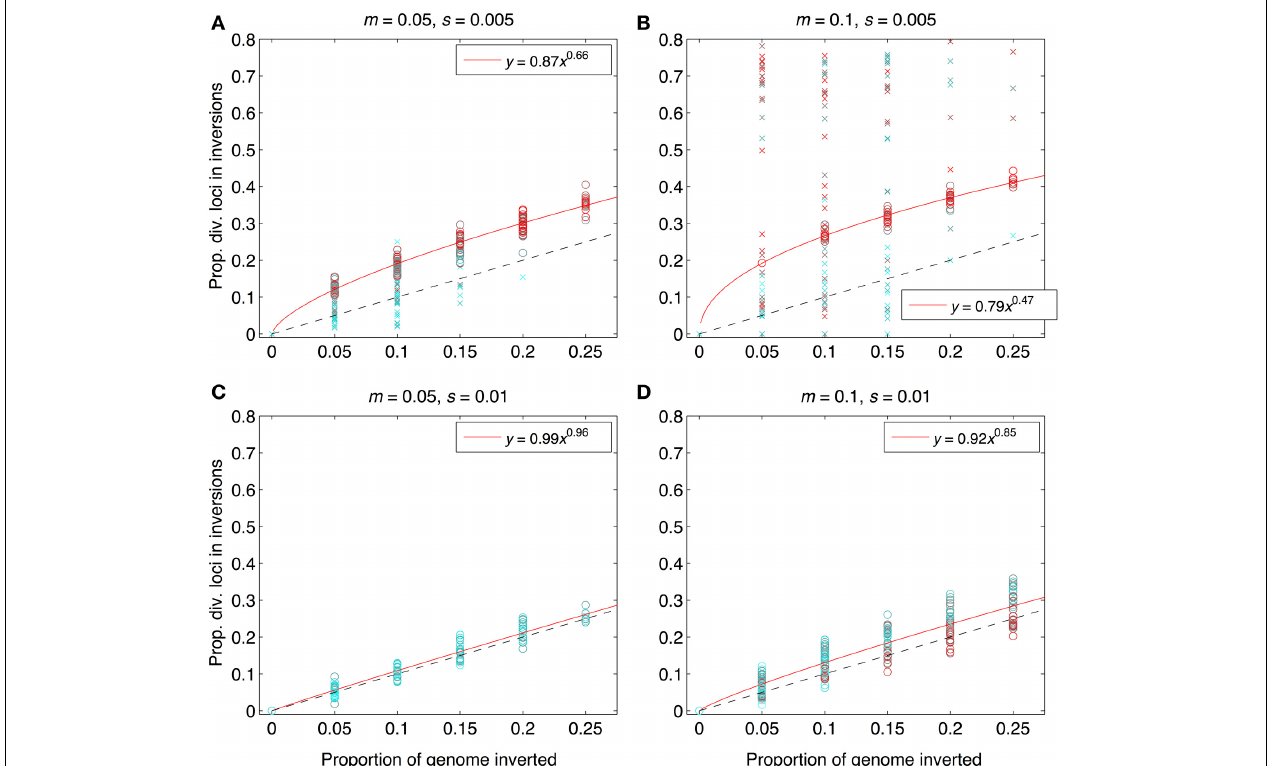
FIGURE 3 | Proportions of divergent loci found within inverted regions for the same set of simulation runs as in Figure 2. The x-axis shows the proportion of the genome with segregating inversions; the y-axis shows the proportion of divergent loci located within inversions. Both were measured at the end of each of 984 simulation runs. Interpretation of symbol shapes and colors is the same as in Figure 2 . The black, dashed line is the null expectation (1:1) if inversions have no effect. Solid, red lines